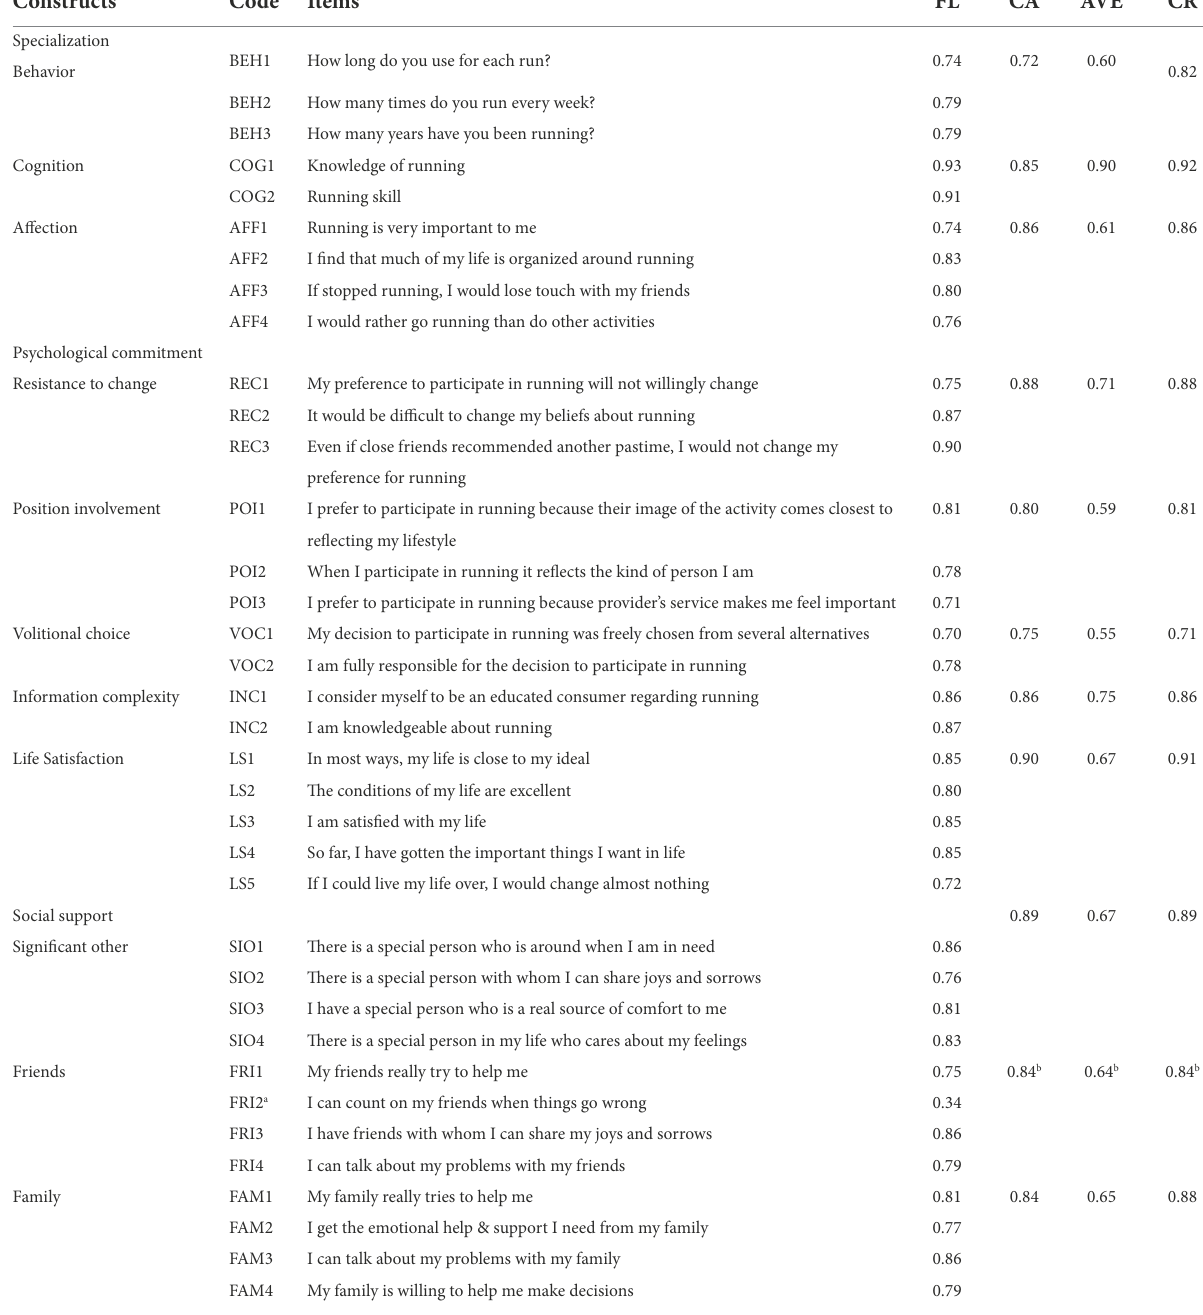
TABLE 2 FL, CA, AVE, and CR of each